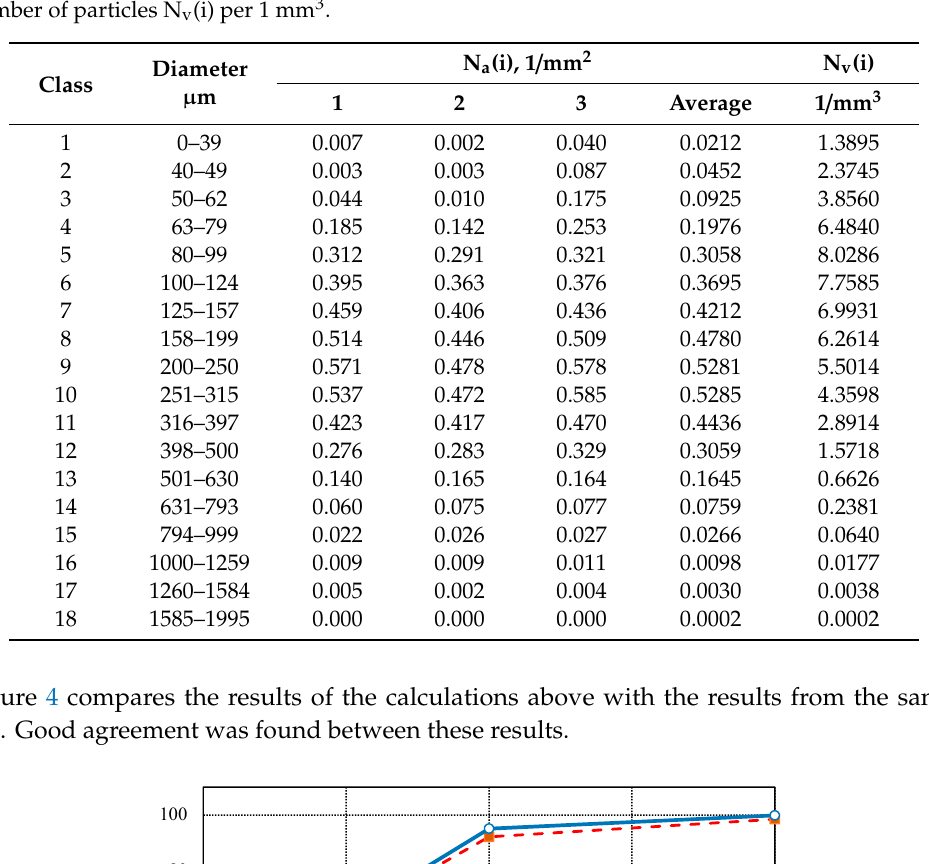
Table 2. Concrete composition data.